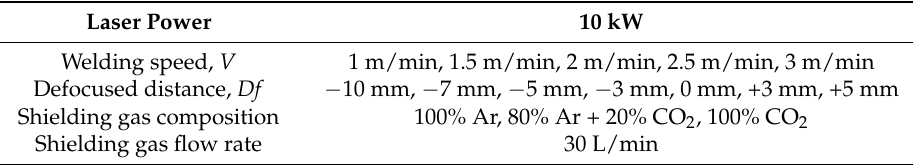
Table 2. Welding